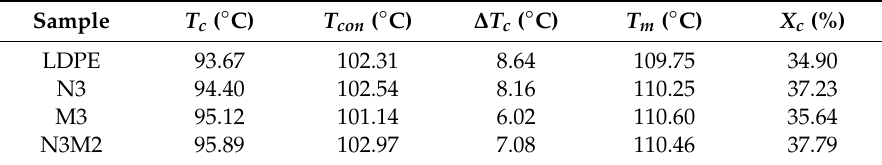
Note: T m , melting peak temperature; T c , crystallization peak temperature; T con , initial crystallization temperature; Δ T c , width of exothermic crystallization peak; X c , crystallinity.